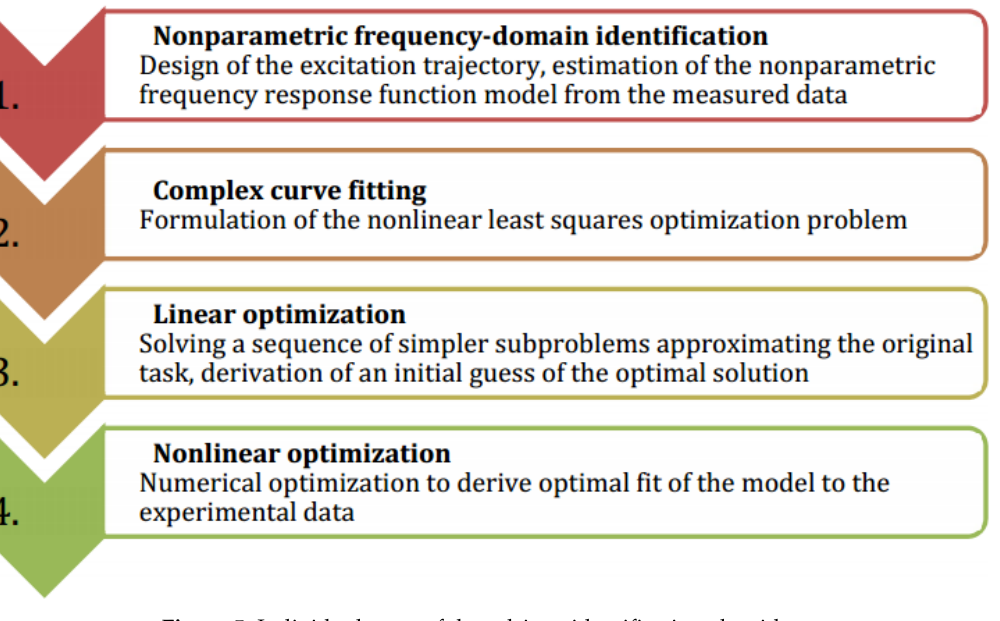
Figure 5. Individual steps of data-driven identification